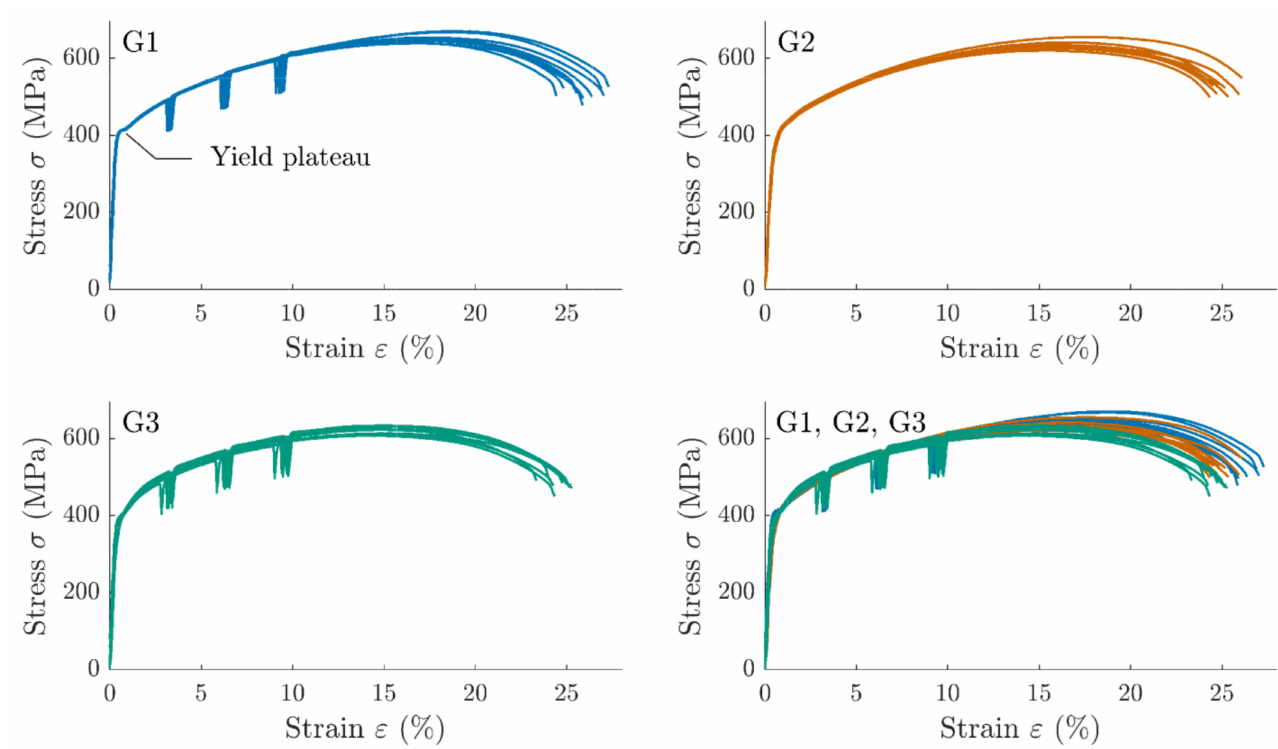
Figure 3. Strain–stress curves of tensile tests with relaxation for the G1, G2, and G3 groups.